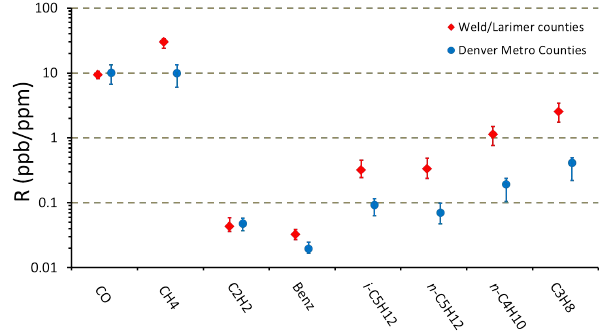
Fig. 6. Observed tracer/CO 2 ff ratios from Weld County (N/E wind sector, red diamonds) and the Denver metro counties (S wind sector, blue circles). Ratios are calculated as the median of the point-by- point ratios for all data where CO 2 ff was detected above 1.2ppm, as described in Sect. 3.3. Uncertainties in the median ratios are the 95% confidence intervals, defined as the 2.5–97.5 percentile range ( ∼ 2 σ confidence) from a distribution of 500 median estimates from a randomized re-sampling of the data (boot-strapping with replace- ment). Note that the figure is presented using a logarithmic